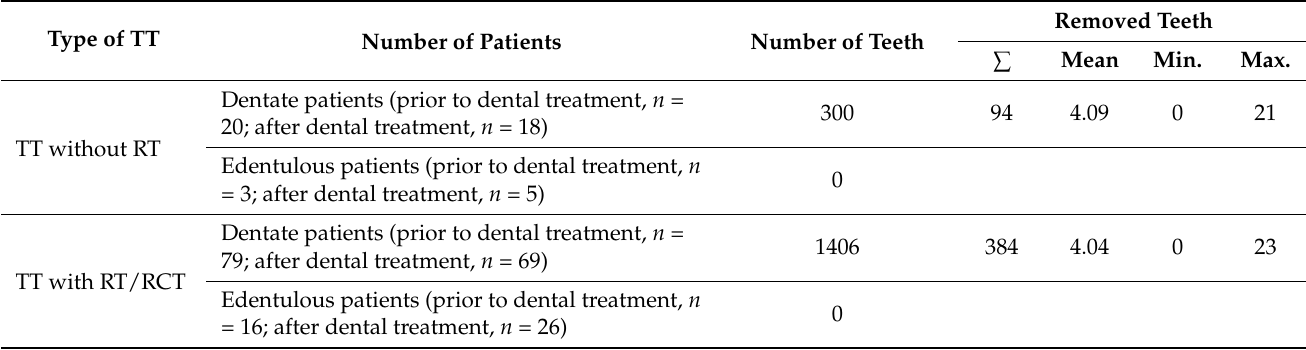
Table 2. Scope of dental treatment in dentate patients in relation to TT, with and without RT.